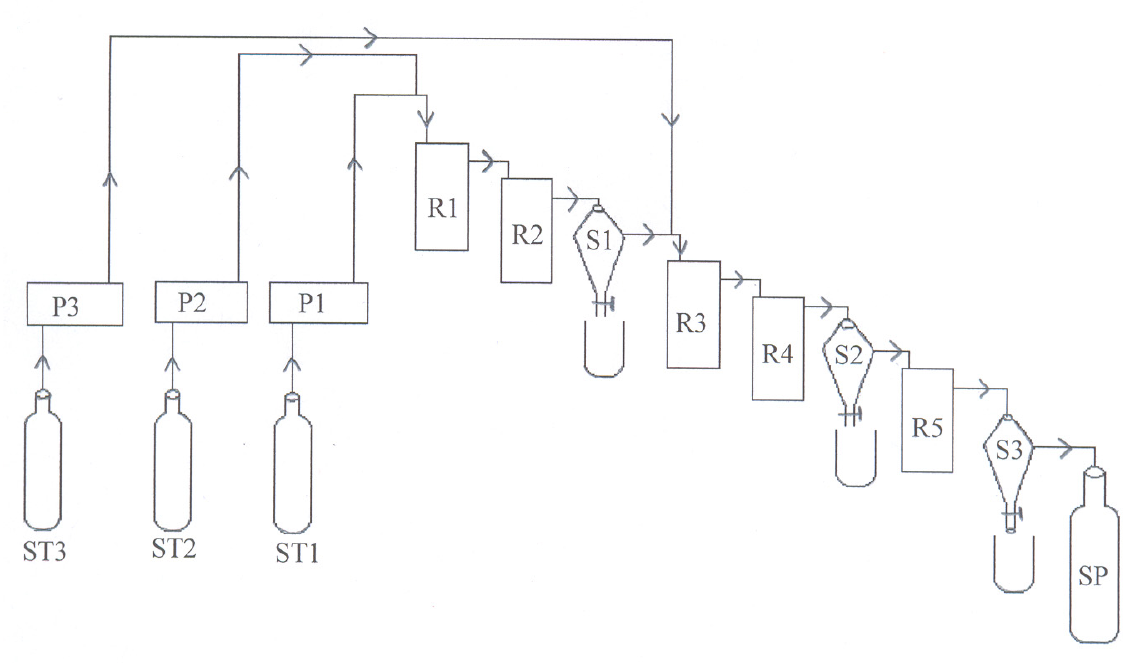
Figure 7. Flow diagram for the continuous transesterification process. (ST1, ST2, ST3) storage tanks, (P1, P2, P3) peristaltic pumps, (R1, R2, R3, R4, R5) continuous stirring tank reactors, (S1, S2, S3) separating funnels, (SP) sample